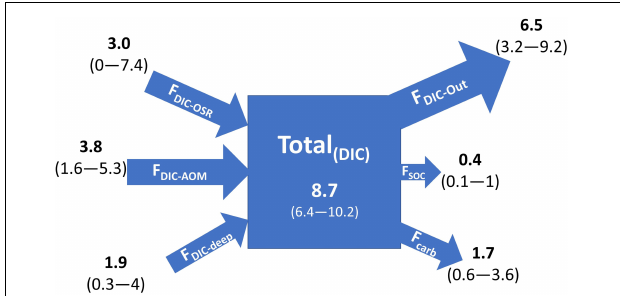
FIGURE 4 | Sources and sinks of DIC through the SMTZ in methane-charged shallow sediments. The numbers in bold indicate flux values in Tmol year - 1 . Numbers in the parentheses indicate the flux values with an extended range of parameters considered in Table 1 . Size of the arrows indicates relative DIC flux